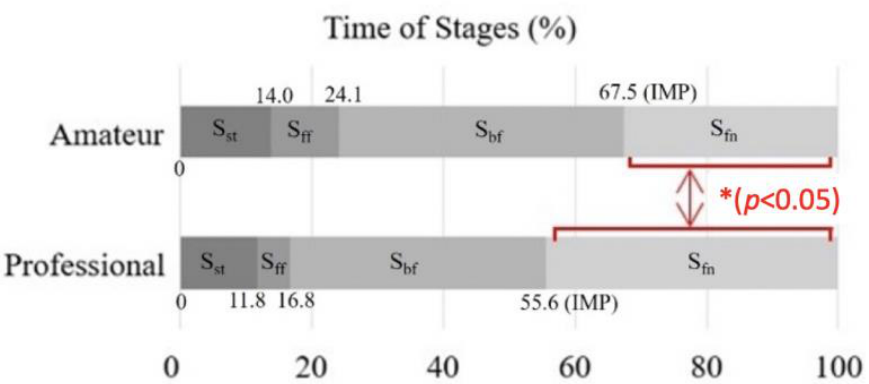
Figure 3. This chart shows the time percentage and timing of the four swing stages of the two groups. In stage S fn , the percentage of the amateur batter’s time was significantly lower than professional batters. (*: p < 0.05).